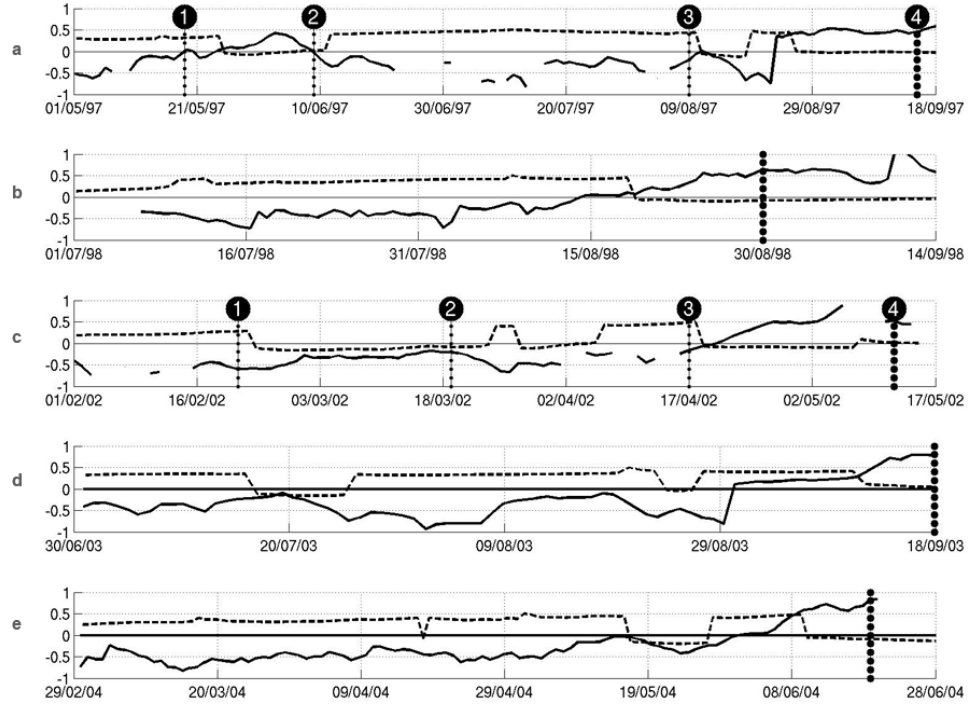
Fig. 6. Time series of two indices used to determine the LC state and LCE separation. The dashed line is the length of the 17-SSH contour whereas the continuous line depicts the LCBsd slope index. Each panel represents conditions during 5 different shedding periods of the numerical simulation corresponding to May–August 1997, June–August 1998, February–April 2002, July–September 2003, and March– June 2004, respectively. The vertical dashed line indicates the final separation date determined from analysis of the FTLE field (see text). Numbers and vertical dotted lines in (a) and (c) are explained in Figs. 4 and 5. Drops in the SSH index suggest the LCE is separated and remains in that stage as long as the value of this index remains small. The slope index indicates there will be an LCE detachment once its sign changes from negative to positive. Note that on several occasions the SSH index suggests the eddy is separated whilst the slope index indicates the eddy is still connected (see text).